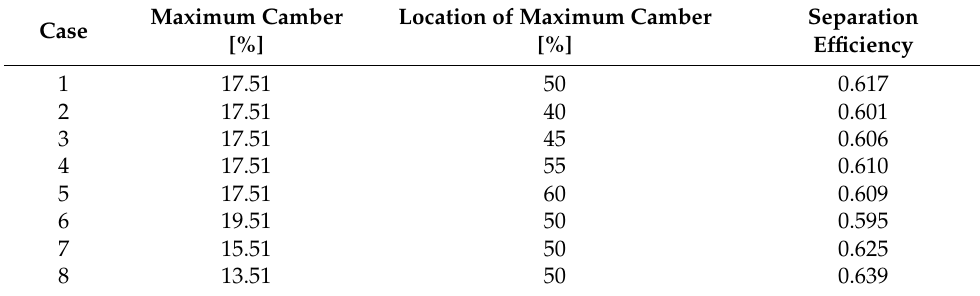
Table 5. Separation